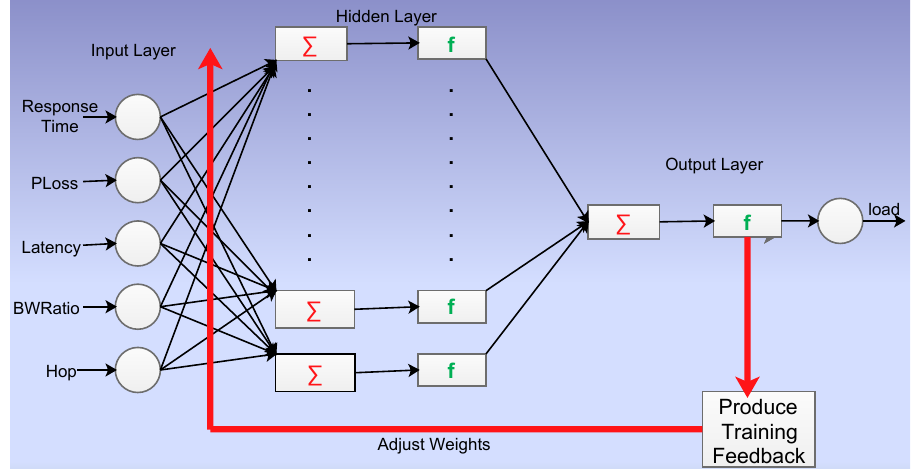
Figure 5. Load balancing neural network